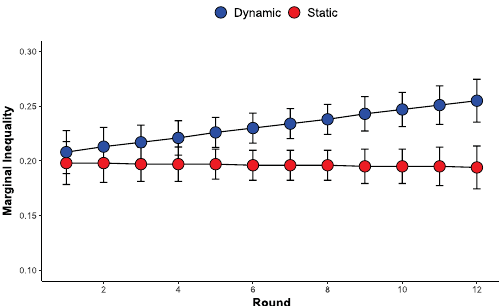
Figure 4. Marginal inequality (Gini coefficients) in the heterogeneous networks. Error bars refer to 95% confidence intervals around the marginal